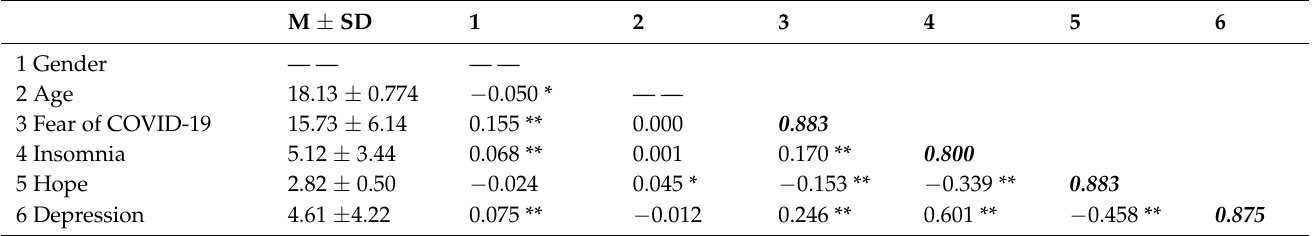
Table 2. Descriptive statistics and correlations between